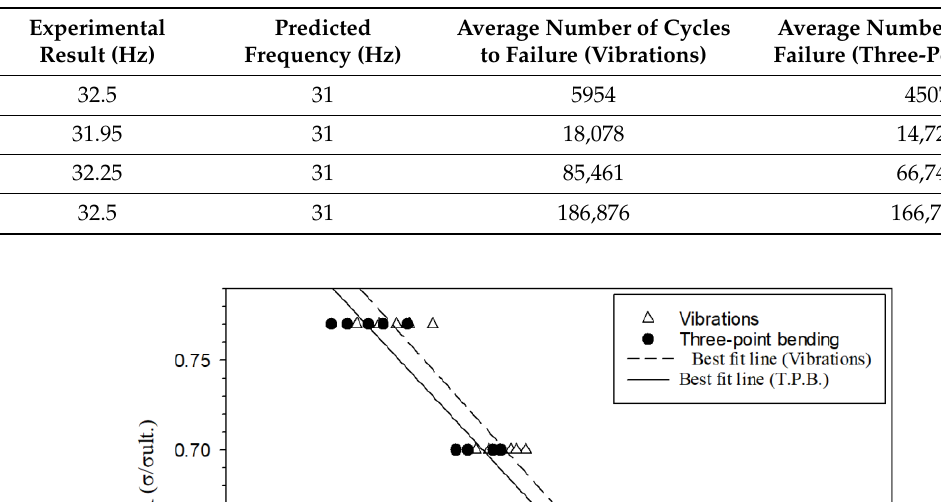
Table 2. Experimental results from Vibration and Three-Point Bending tests.